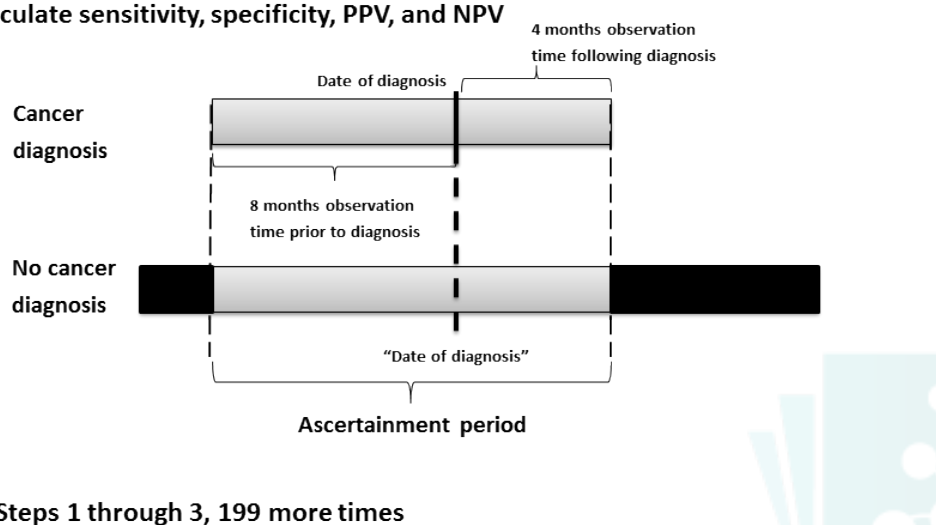
The period of time in the data selected to ascertain the presence or absence of an anticancer medicine dispensing; and the iterative nature of the process. GC = Gold Card; RPBS = Repatriation Pharmaceutical Benefits Scheme; PPV = positive predictive values; NPV = negative predictive